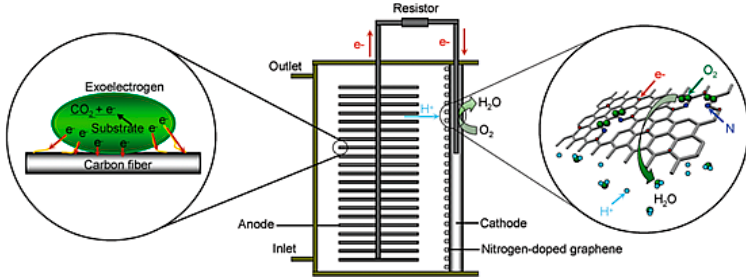
Figure 8. Schematic diagram of a membrane-free single chamber MFC operated with N-doped graphene coated carbon cloth (CC) as the air-cathode showing the basic mechanism of current generation. (Reprinted with permission from Ref. [81]. Copyright (2011) American Chemical Society).